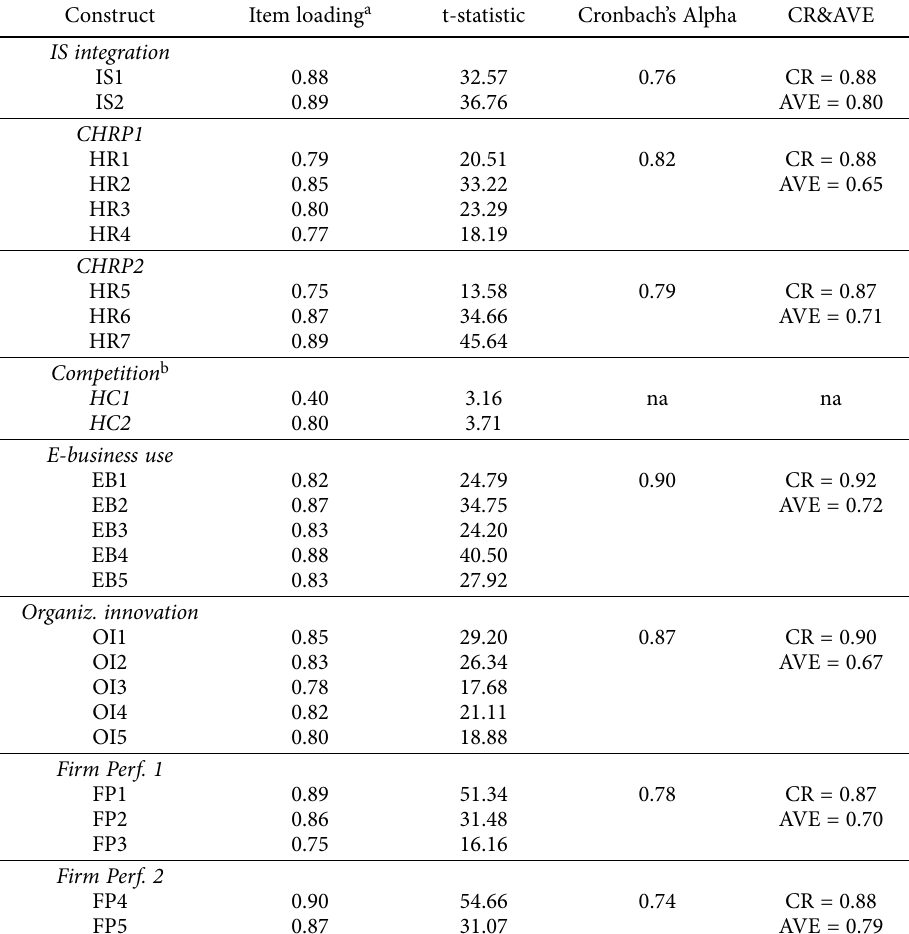
Table 2. Reliability and convergent